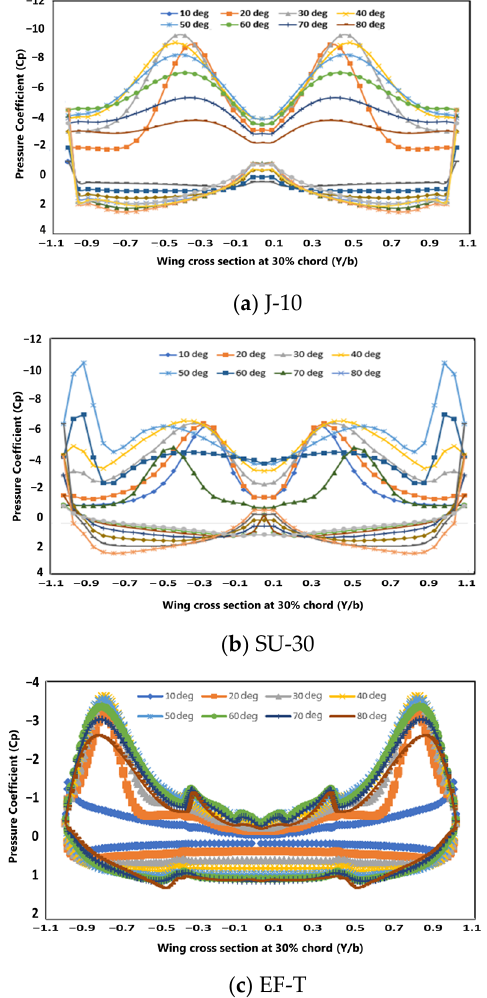
Figure 10. Pressure distribution (Cp) at 30% chord root; ( a ) J-10; ( b ) SU-30; ( c )